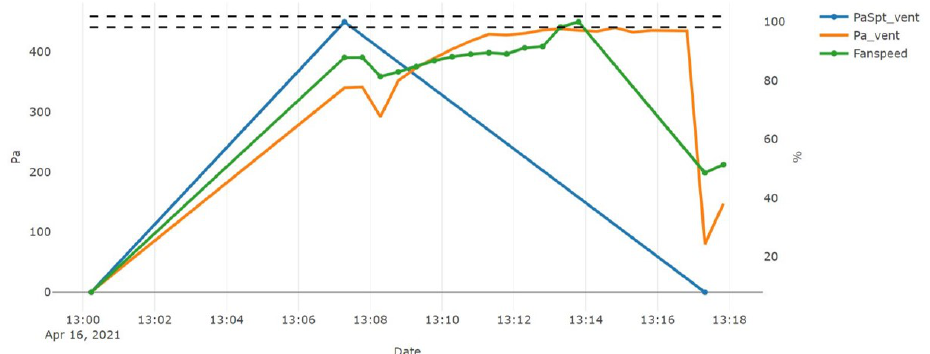
Figure 15. Time step response of the ventilation setup: unstable